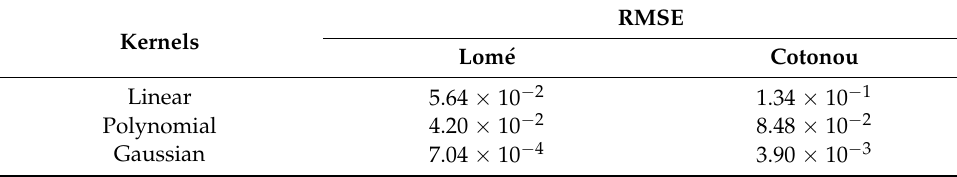
Table 8. Kernel Table 8. Kernel comparison.